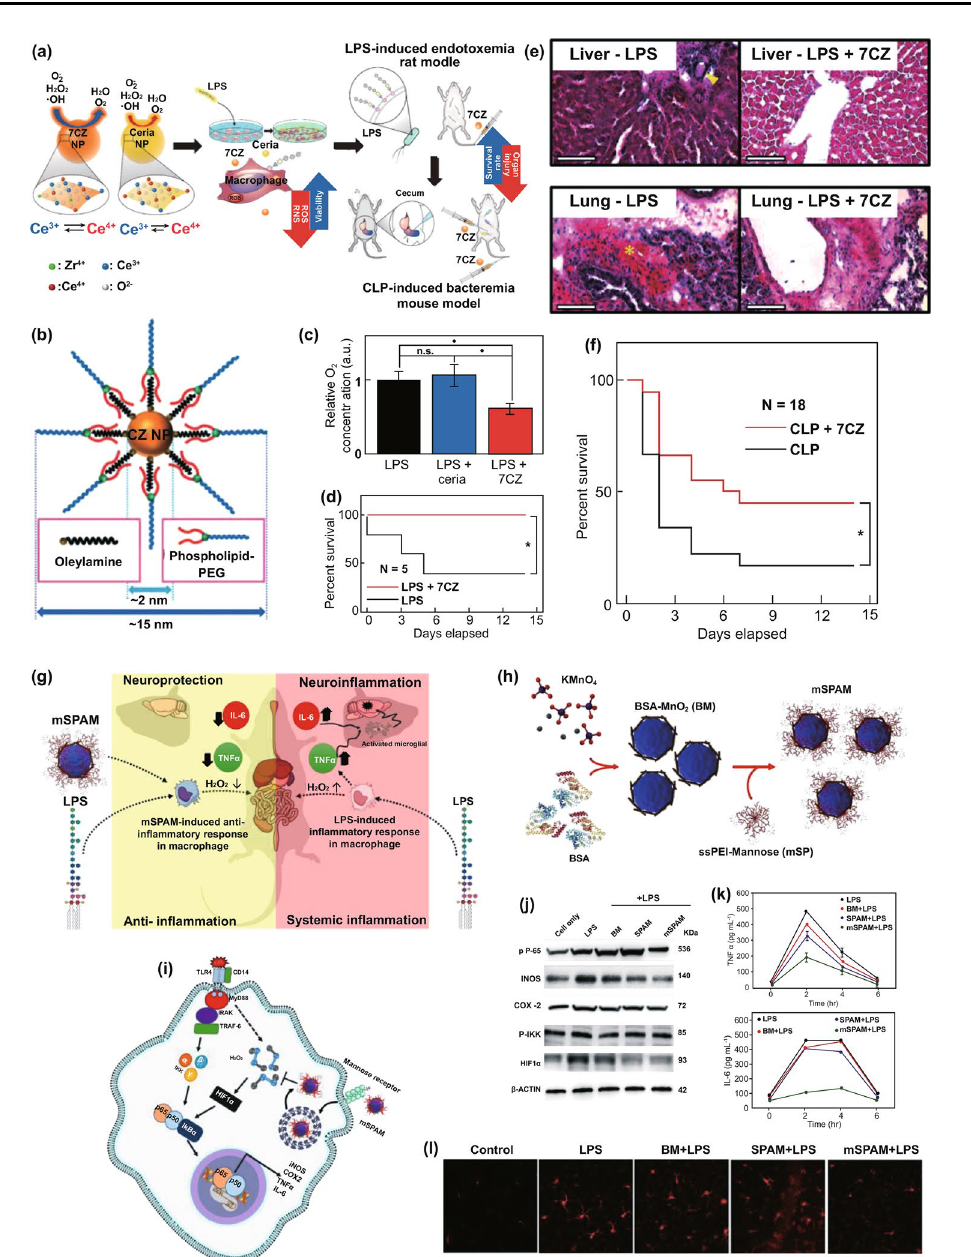
Fig. 15 Ceria-zirconia nanoparticles with enhanced multiantioxidant effects for sepsis treatment. a Schematic illustration of CZ NPs as thera- peutic nanomedicine for controlling in vitro inflammation and in vivo sepsis. b Schematic illustration of CZ NPs. c Relative O 2− level measure- ment of LPS-challenged U937 cells after treatments with vehicle, ceria NPs and 7CZ NPs. d Survival rates of LPS-induced septic mice undergo- ing therapeutics with nontreatment and 7CZ NPs. e Representative histopathological images of liver and lung extracted from LPS-induced septic mice with/without 7CN NP treatment. f Survival rates of CLP models with/without 7CZ NP therapy. Reproduced with permission from Ref. [230]. Copyright 2017 John Wiley and Sons, Inc. Peroxidase-mimicking nanoassembly with potent antioxidative effects for attenuating inflam- mation for the management of LPS-induced sepsis. g Schematic illustration of mSPAM-mediated anti-inflammatory response in both systemic inflammation and neuroinflammation. h Rational design and fabrication of mSPAM. i Schematic illustration of mSPAM nanoassembly alleviat- ing proinflammatory response in LPS-challenged macrophages by reducing H 2 O 2 accumulation. j Western blot analysis of proteins in NF-κB pathway in RAW264.7 cells treated with mSPAM nanoassembly. k ELISA analysis of TNF-α and IL-6 level at different time points in serum from LPS-induced mice with various treatments. l IBA-1 fluorescence staining of mouse brain. Reproduced with permission from Ref. [233]. Copyright 2018 American Chemical